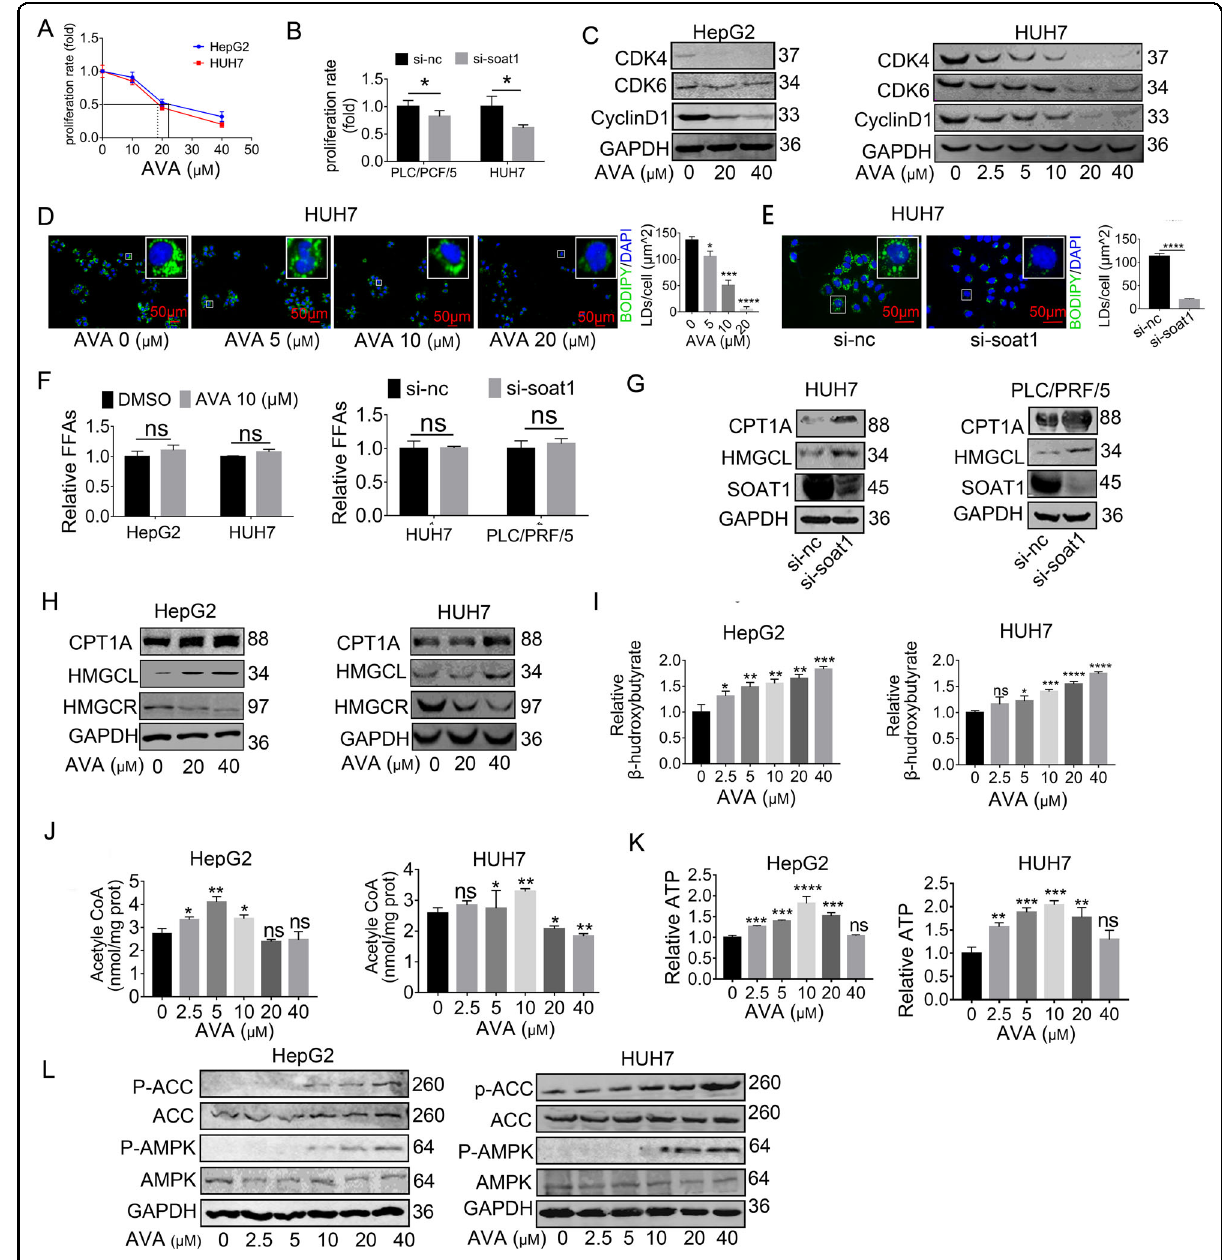
Fig. 4 SOAT1 inhibition upregulates CPT1A expression, which shuttles released FFAs into mitochondria for oxidation in vitro. A – B CCK8 assay showed that SOAT1 knockdown inhibited cell viability in HepG2 and HUH7, (mean± SEM, n = 3), * p < 0.05. IC50 values of avasimibe (AVA) were about 20 μ m. C Western blot analysis of CDK4, CDK6, and cyclinD1 protein with AVA treatment. D – E Fluorescence imaging of LDs stained with BODIPY 493/503 (green) in HUH7 treated with pharmacological (avasimibe, 48 h) or genetic (si-RNA, 72 h) inhibition of SOAT1. Nuclei were stained with DAPI (blue). Scale bar, 50 μ m. More than 30 cells were analyzed. Data were quanti fi ed using ImageJ software; * p < 0.05; *** p < 0.001, **** p < 0.0001. Signi fi cance was determined by unpaired student ’ s t -test. F The level of total free fatty acids in HCC cells treated with SOAT1 inhibition. (mean± SEM, n = 3), ns, no signi fi cance. G – H Western blot analysis of CPT1A and HMGCL in HepG2 and HUH7 treated with pharmacologic o r genetic SOAT1 inhibition. I – K Levels of total acetyl-CoA, ATP, and β -hydroxybutyrate in HCC cells treated with avasimibe (AVA) for 48 h at an indicated concentration (mean± SEM, n = 3); * p < 0.05; *** p < 0.001, **** p < 0.0001; ns, no signi fi cance. L Western blot analysis of P-ACC (S79), ACC, P- AMPK (T172), and AMPK in HCC cells treated with AVA for 48 h at the indicated